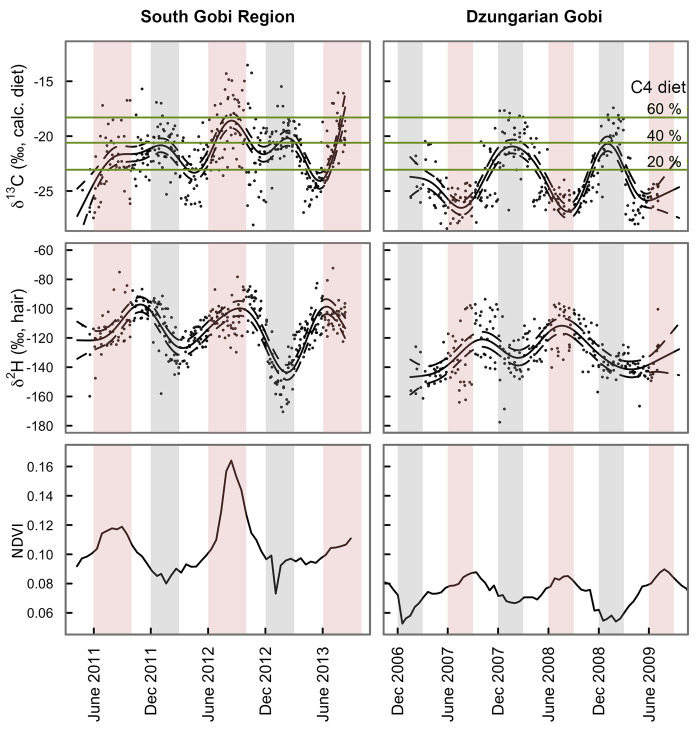
Isotope profiles of khulan tail hair.Sequential, temporally explicit ™13Cdiet, ™2Hhair profiles of khulan tail hair and time-matched 16-day NDVI values. The fraction of C4 biomass in the diets takes into account the isotopic variability of the C3 and C4 end members used in the mixing model (mean ™13C ± 1σ, depicted with solid and dashed line, respectively). Pink and gray stripes depict summer and winter, respectively.